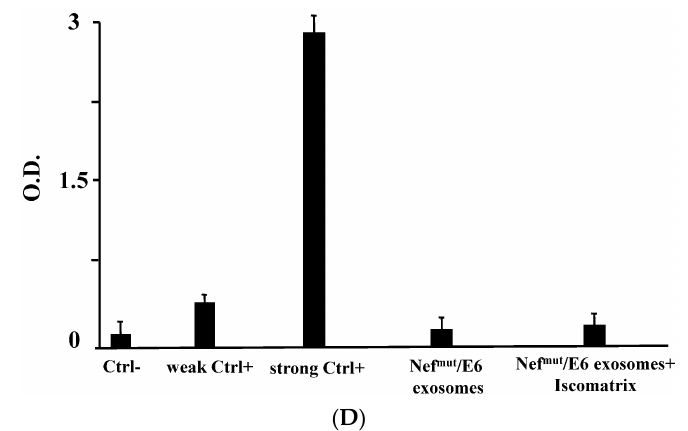
Figure 5. The co-inoculation in mice of ISCOMATRIX TM adjuvant and engineered exosomes increases the number of HPV-E6 specific CD8 + T lymphocytes. ( A ) molecular characterization of exosome preparations uploading Nef mu /HPV-E6. On the left is the Western blot analysis of 200 µU of exosomes associating Nef mut /E6. As a control, equivalent amounts of exosomes from cells transfected with the empty vector were loaded. Arrow signs indicate the relevant protein product. Exosome preparations were also probed for the presence of ICAM-1. Molecular markers are given in kDa. On the right, the FACS analysis for the presence of CD63 in exosome membrane is shown. M1 marks the range of fluorescence positivity as determined by the analysis of equivalent amounts of exosomes after incubation with isotype-specific IgGs ( left histogram). Results shown in both panels are representative of five assays carried out on three exosome preparations. At the bottom right, mean values ±SD of both percentages of positivity and MFI from the five assays are also reported; ( B ) CD8 + T cell immune response in mice inoculated with Nef mut /E6 exosomes in the presence or not of ISCOMATRIX TM adjuvant. C57 Bl/6 mice (three per group) were inoculated s.c. at the lower right flank three times with exosomes uploading Nef mut /E6 in the presence or not of the adjuvant. Two weeks after the last inoculation, splenocytes were isolated and 10 5 cells were incubated overnight with or without 5 µg/mL of either unrelated or HPV-E6-specific peptides in IFN-γ Elispot microwells in triplicate conditions. As a control, untreated cells were incubated with 10 ng/mL of phorbol-12-myristate-13-acetate (PMA) and 500 ng/mL of ionomycin. Afterwards, cell activation extents were evaluated by IFN-γ Elispot assay carried out in triplicate with 10 5 cells/well. Cultures of splenocytes from each inoculated mouse were carried out separately. The mean of SFU/10 5 cells calculated on the basis of data reported at the bottom which were obtained in two independent immunization experiments are shown. Iscomatrix: ISCOMATRIX TM adjuvant; ( C ) Cytotoxic T lymphocyte (CTL) assay carried out with CD8 + T cells isolated from splenocytes of mice inoculated with exosomes uploading Nef mut /E6 in the presence or not of ISCOMATRIX TM adjuvant. CD8 + T lymphocytes from pooled splenocyte cultures were co-cultivated for 6 h at 20:1 effector/target cell ratio with EL (European lymphoblast)-4 cells previously labeled with Carboxyfluorescein succinimidyl ester (CFSE), and treated with either unrelated or E6 peptides for 16 h. Finally, the EL-4 cell mortality levels were scored by FACS analysis upon 7-AAD labeling. At the top , are the results obtained using pooled splenocytes from a representative of two independent immunization experiments. At the bottom , the dot-plot FACS analysis of the co-cultures is reported. Cells were gated on the basis of their apparently unaffected morphology, and the percentages of double-positive over the total of CFSE-labelled cells are reported; ( D ) anti-E6 antibody detection in plasma from mice inoculated with the Nef mut /E6 exosomes in the presence or not of ISCOMATRIX TM adjuvant. Plasma were tested in an in-house Elisa assay upon 1:10 dilution. As internal standards, 1:10 diluted plasma from mock-inoculated mice was used as negative control (Ctrl−), whereas both 1:1000 (weak Ctrl+) and 1:100 (strong Ctrl+) dilutions of plasma from mice injected with 10 µg of recombinant E6 protein plus adjuvant were used as positive controls. Shown are the mean absorbance values +SD of triplicates of plasma samples from each inoculated mouse.